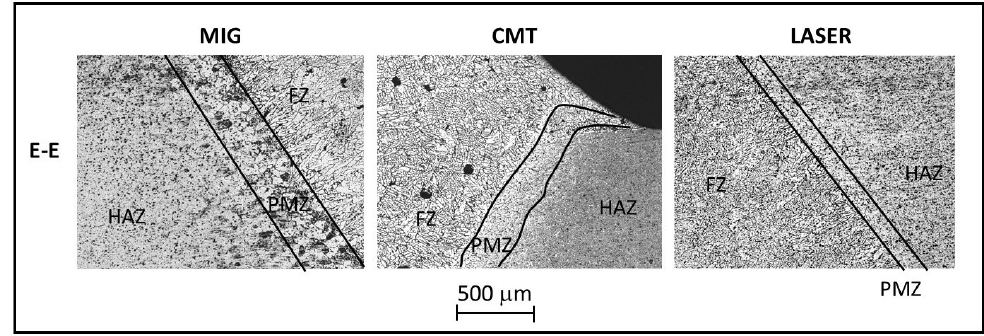
Figure 9. Macrostructures of the interface between the HAZ, PMZ, and FZ in the Extruded-Extruded